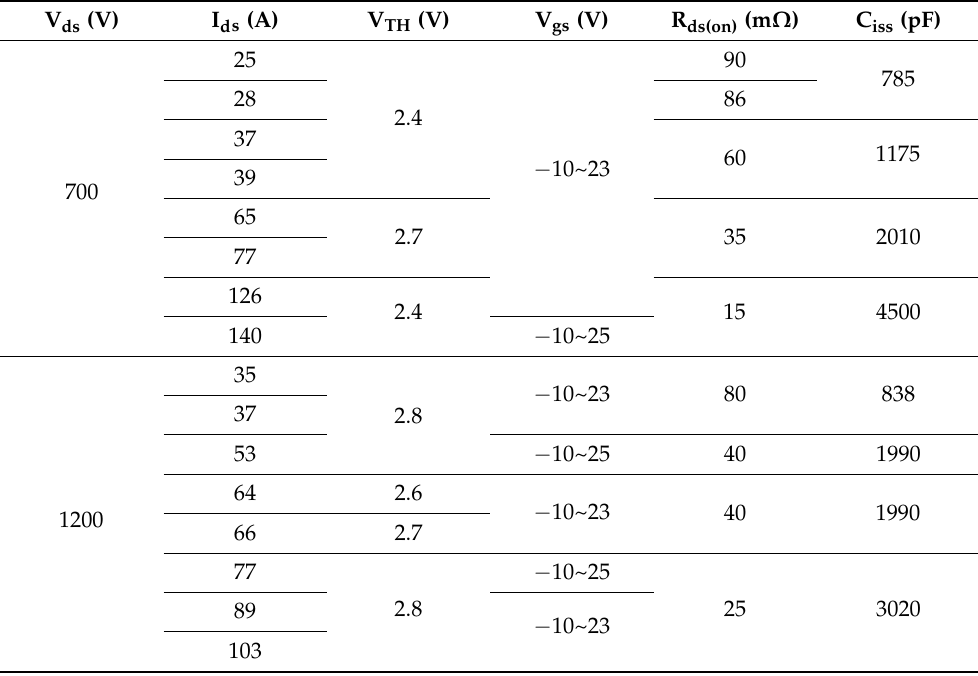
Table 11. Commercial 600~1200 V SiC MOSFETs by Microchip.